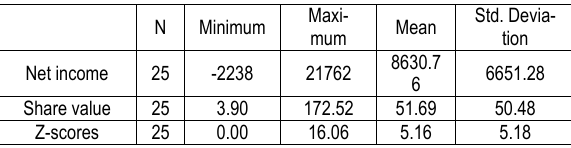
Table 2. Descriptive Statistics from 2010 to 2014